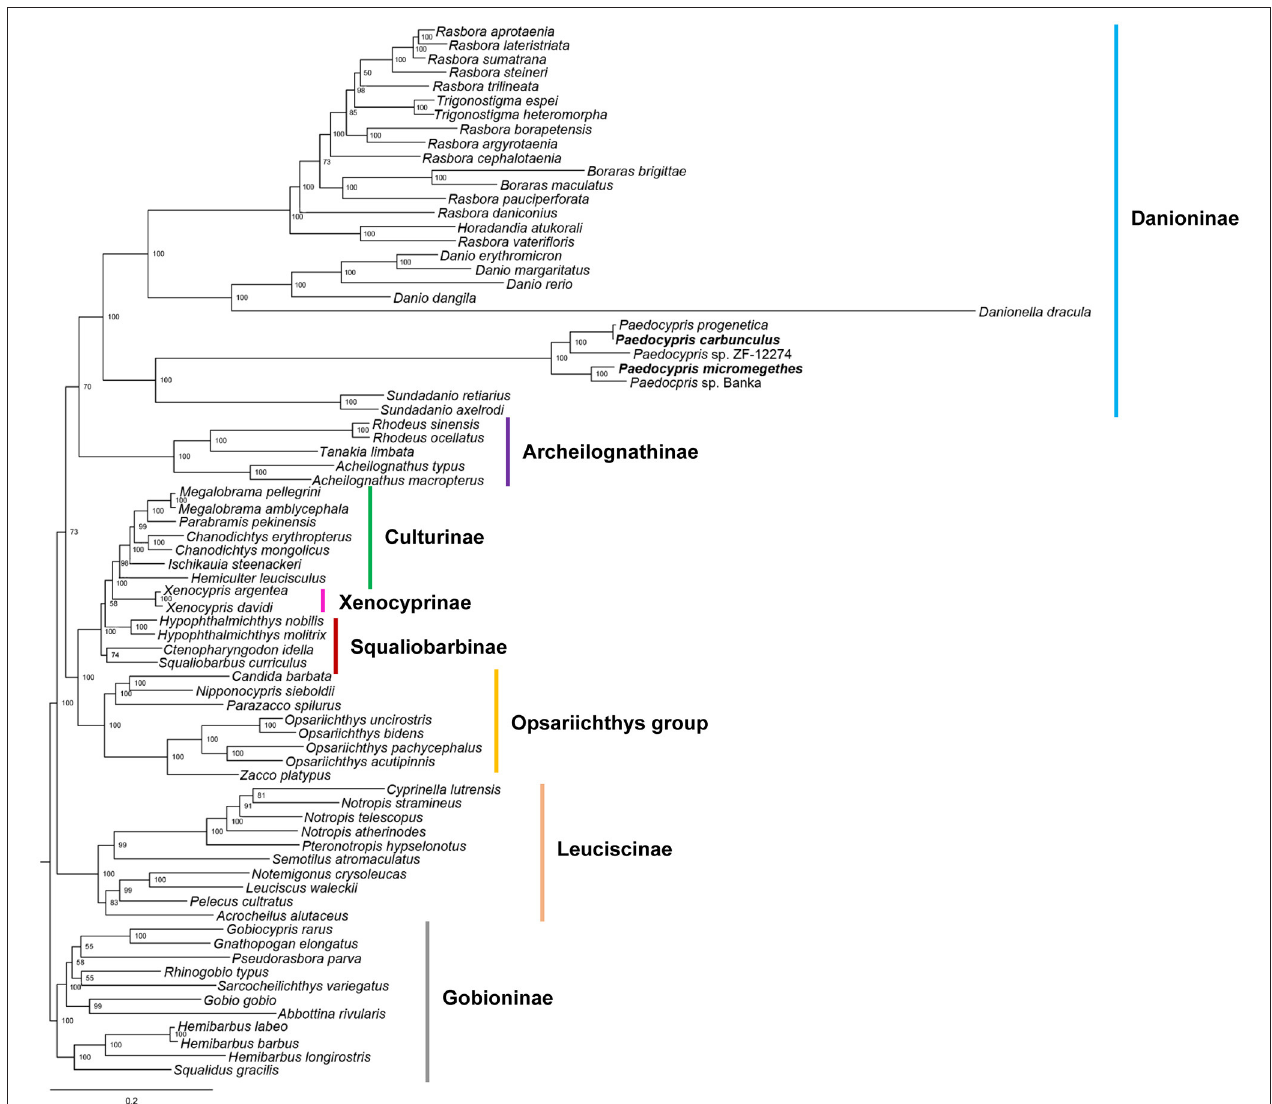
FIGURE 2 | Phylogenetic tree inferred from nucleotide sequences of 13 protein-coding genes and two rRNAs of the mitogenomes using maximum likelihood analysis. The numbers along branches include bootstrap values. The sequences generated in this study are indicated in bold font.